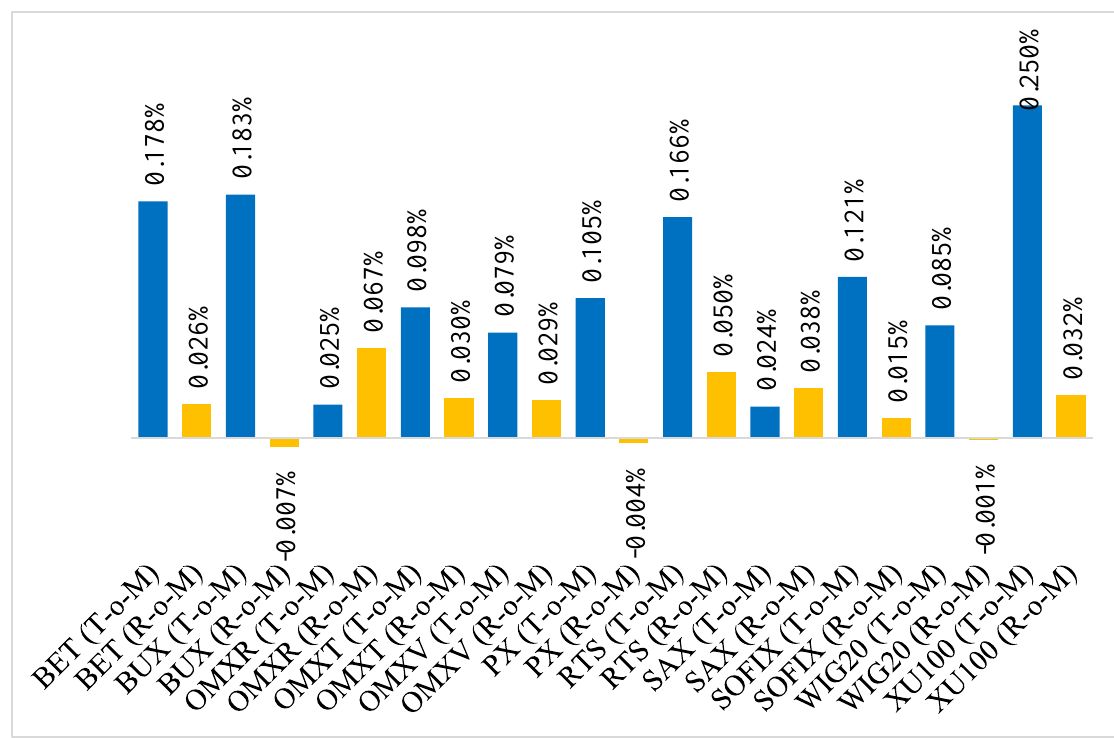
Figure 3. Comparison of average daily returns—Turn of the month window (3 + 3). Table 4. Results of the statistical significance tests—Turn of the month window (3+3).